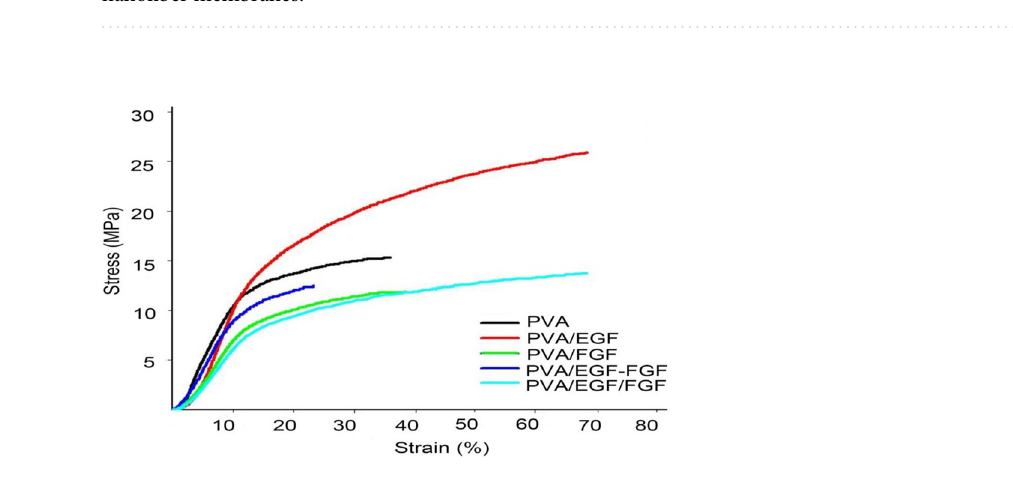
Table 1. Mechanical properties of electrospun PVA, PVA/EGF, PVA/FGF, PVA/EGF-FGF and PVA/EGF/FGF nanofiber membranes.